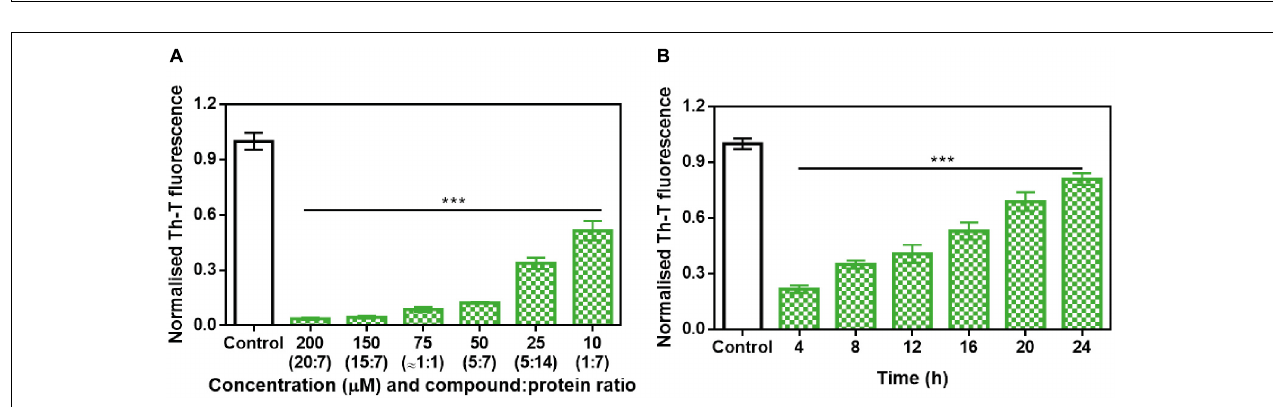
FIGURE 3 | Analysis of the inhibitory capacity of ZPD-2. (A) Titration of the effect of different concentrations of ZPD-2 on 70 µ M α -Syn aggregation. (B) Th-T fluorescence of α -Syn end-point aggregates after the addition of ZPD-2 at different time points during the aggregation kinetics. Th-T fluorescence is plotted as normalized means. End-points were obtained at 48 h of α -Syn incubation. Error bars are shown as standard errors of mean values, ∗∗∗ p < 0.001.